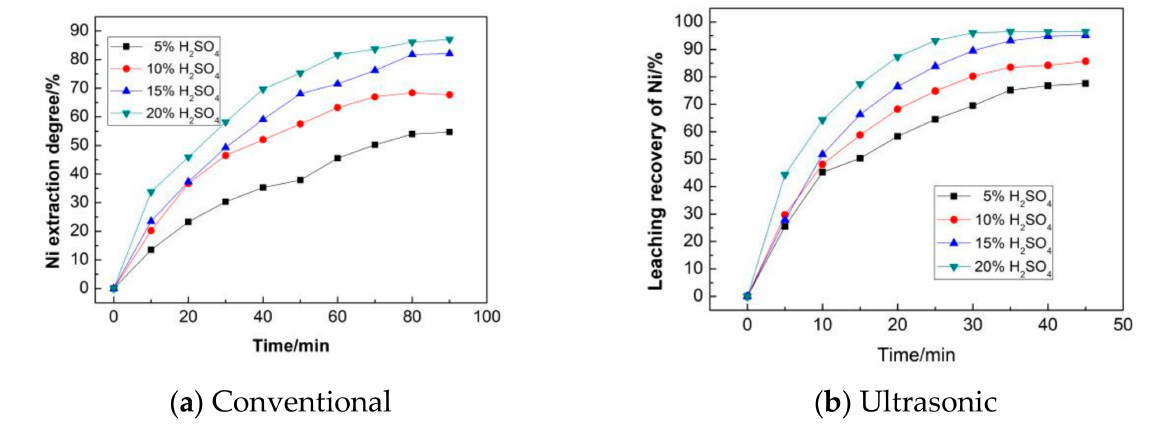
Figure 5. The influence of sulfuric acid concentration on the Ni extraction degree. ( a ) Conventional: temperature = 25 ◦ C, solid-liquid ratio = 1:7, particle size = − 150 µ m, stirring speed = 150 rpm; ( b ) ultrasonic: temperature = 25 ◦ C, solid-liquid ratio = 1:7, ultrasonic power = 600 W, particle size = − 150 µ